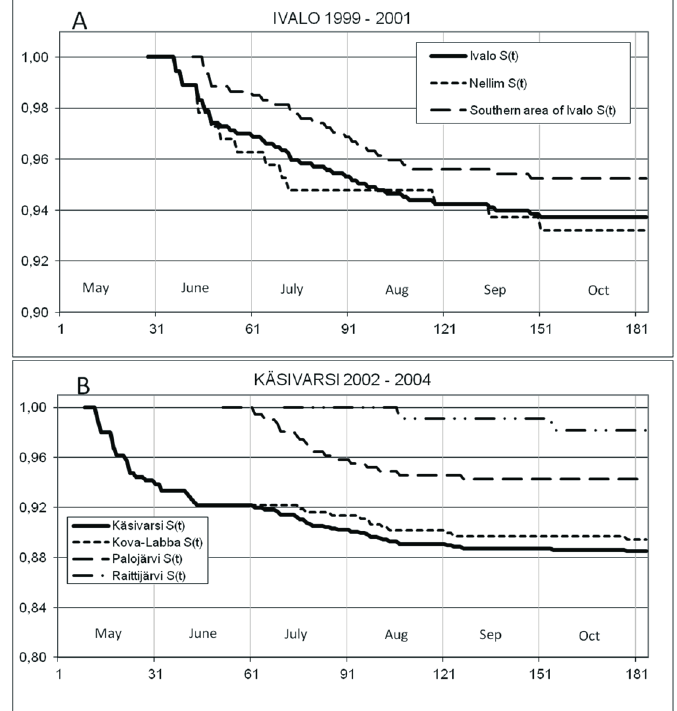
Fig. 2. Survivorship curves for radio-collared reindeer calves (A) in Ivalo cooperative and in its herding-groups during 1999-2001, and (B) in Käsivarsi and its herding-groups during 2002-2004. Day 1 is 1 st of May. (Mortality (M) = 1 – Survival